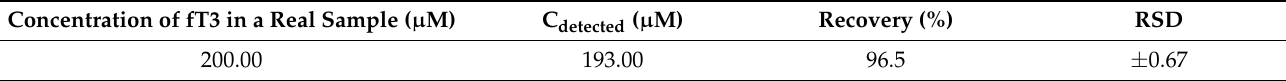
Figure 8. Representative CV scans of GCE/Fe 3 O 4 @graphene/Ab/Lac in the presence of 200 µM fT3 after 21 days. Potential range: − 0.2–1.3 V, scan rate: 50 mV s − 1 , vs. Ag/AgCl electrode, 40 cycles. Table 1. Results obtained for the detection of fT3 in synthetic human